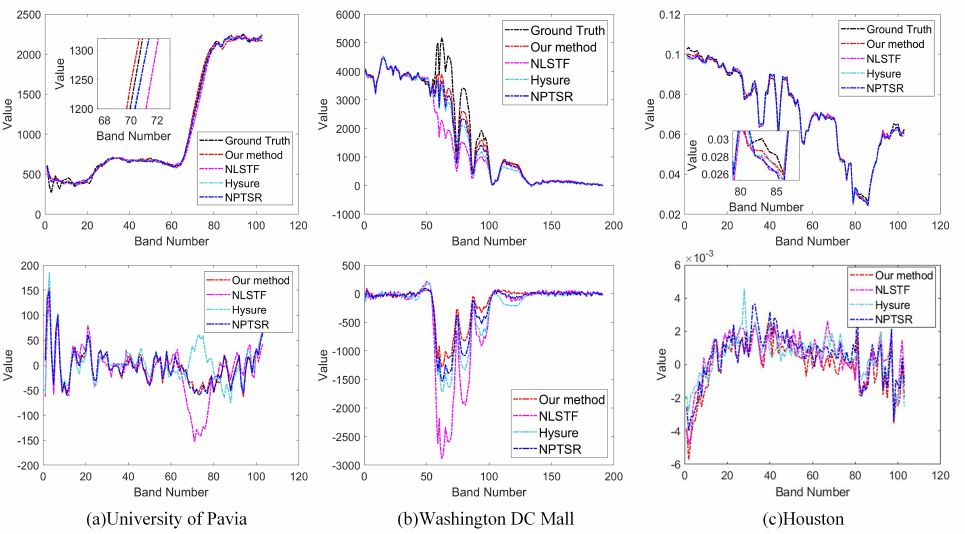
Figure 8. Spectral curve comparison and spectral curve residual comparison for three data